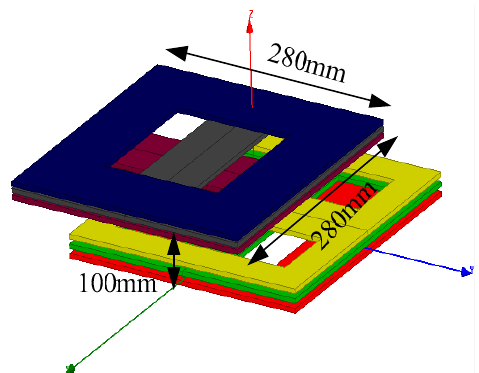
Figure 7. Structure of the proposed DD2Q pads.